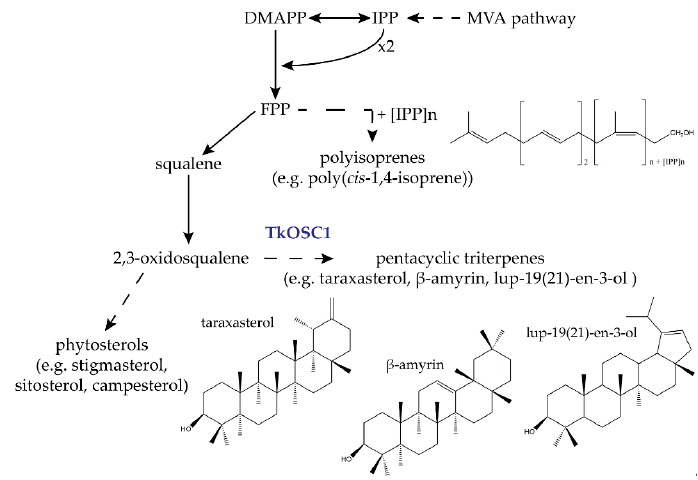
Figure 1. Isoprenoid biosynthesis pathway in T. koksaghyz latex. T. koksaghyz oxidosqualene cyclase 1 ( TkOSC1 ) is a multifunctional OSC that catalyses the formation of several highly abundant pentacyclic triterpenes such as taraxasterol, α -, β -amyrin and lup-19(21)-en-3-ol [9]. Dashed arrows indicate multiple enzyme steps. MVA, mevalonate; DMAPP, dimethylallyl diphosphate; IPP, isopentenyl diphosphate; FPP, farnesyl